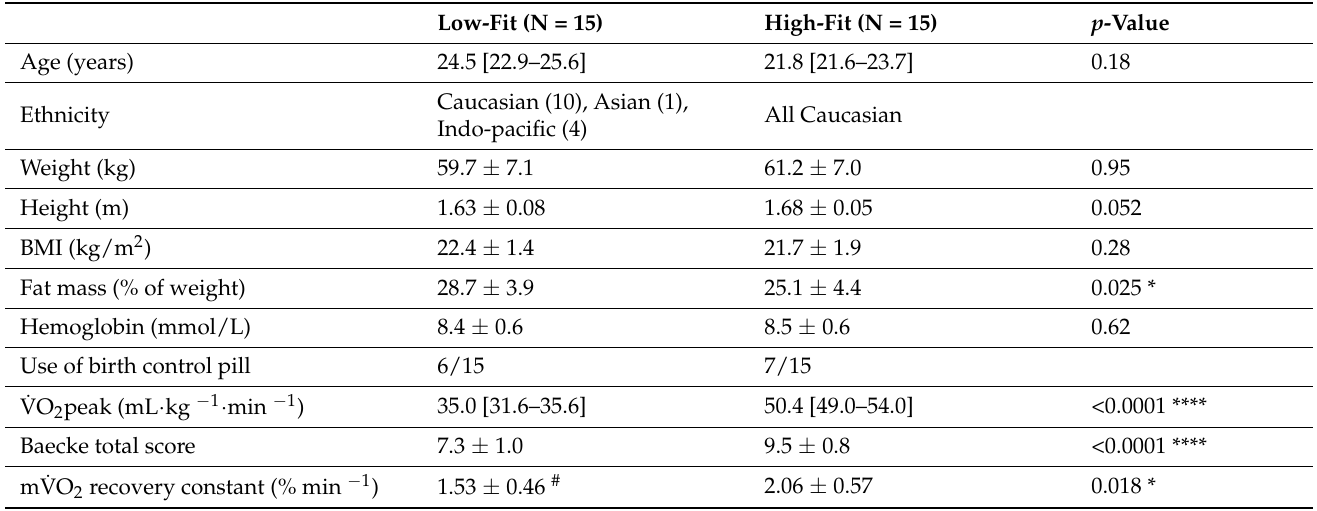
Table 1. Subject